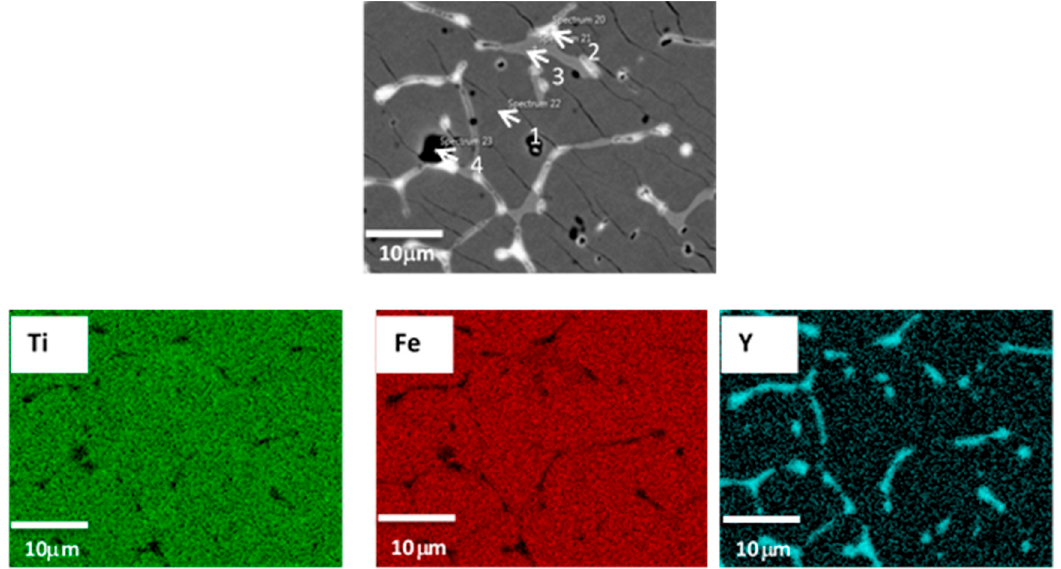
Figure 2. Backscattered micrographs of TiFe + 4 wt.% Y and the corresponding EDX mapping.